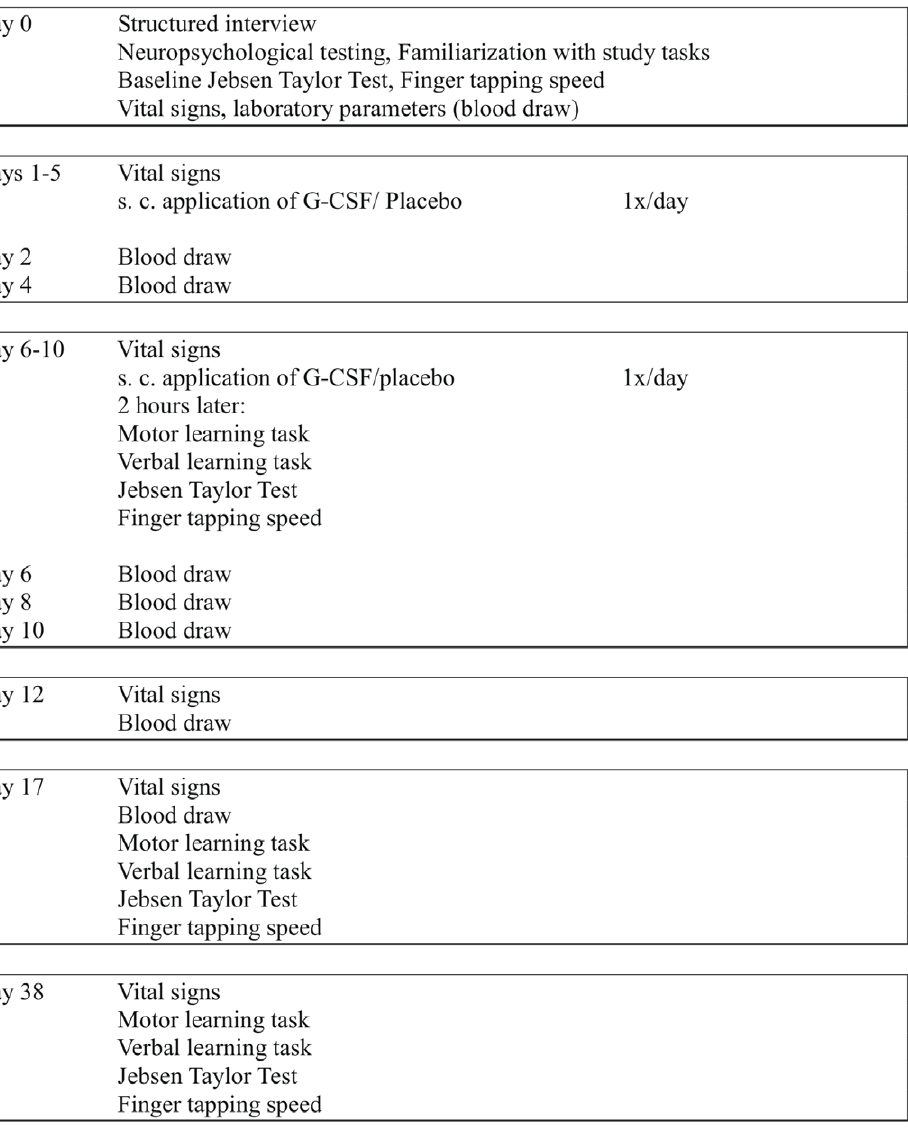
Figure 2. Time schedule of procedures and tests performed. Shown are the different test series performed over 38 days.